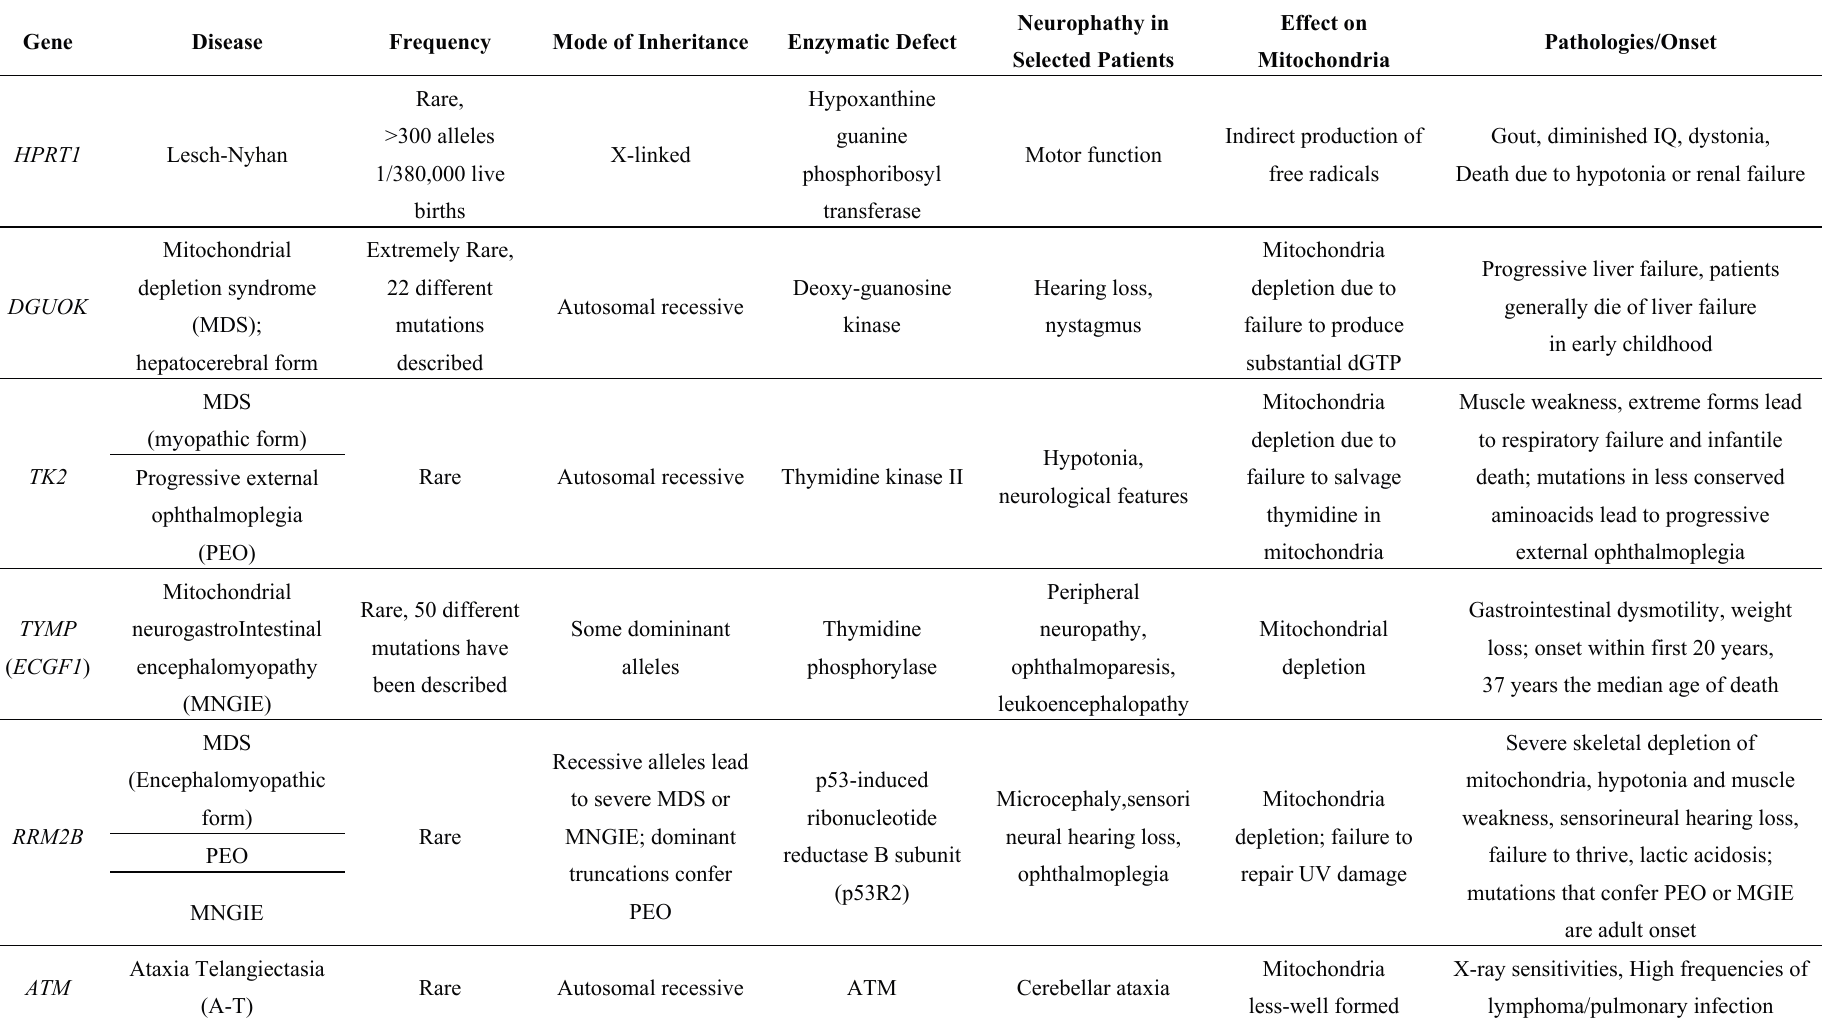
Table 1. Nucleotide metabolism genes and associated genetic